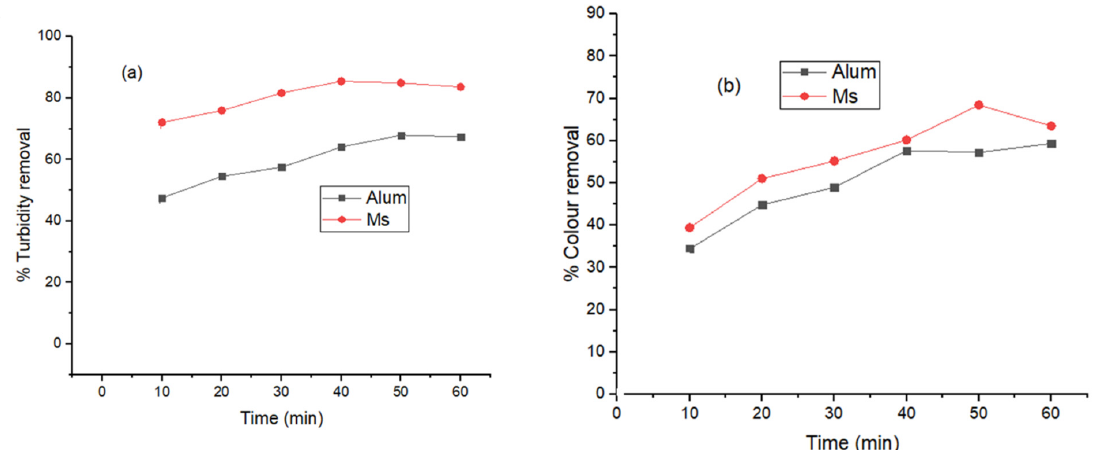
Figure 4. Effects of coagulant dosage (10–60 mg/L) on ( a ) turbidity and ( b ) color removal (%); Ms (red) and Alum (black) without any magnetic influence.